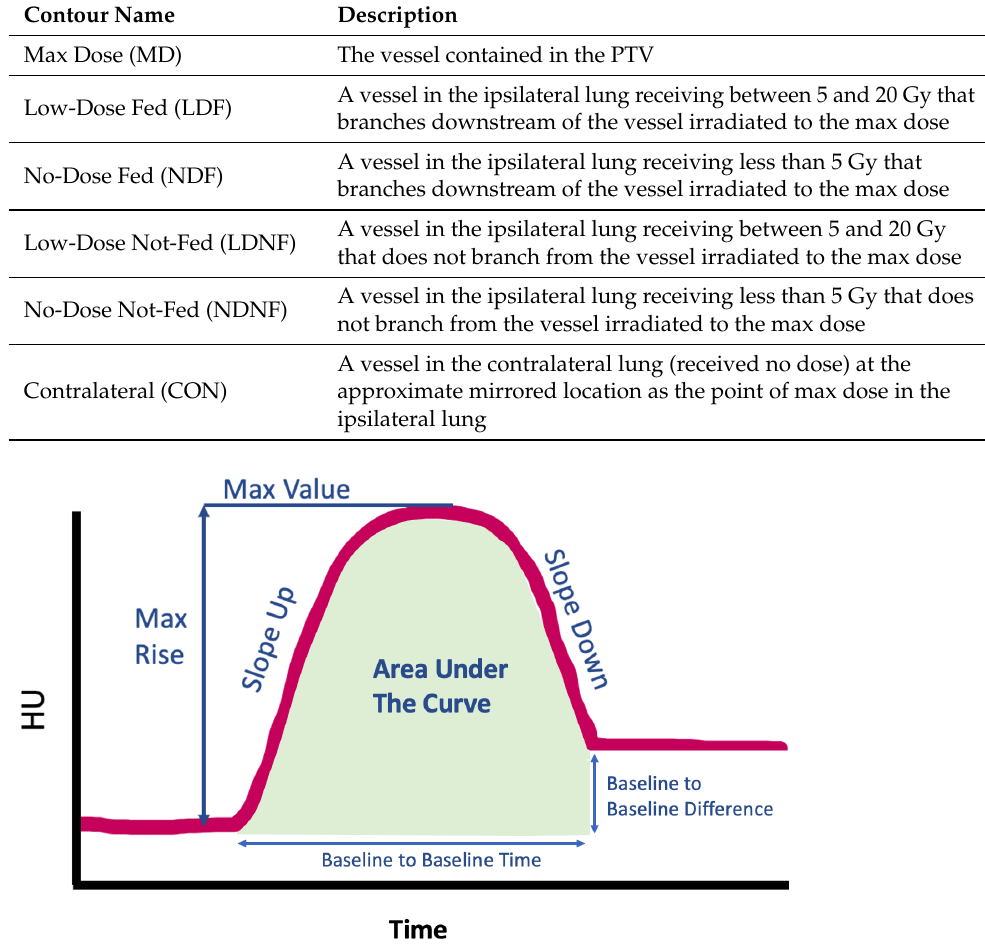
Figure 4. Diagram showing the different measurements that were obtained in each